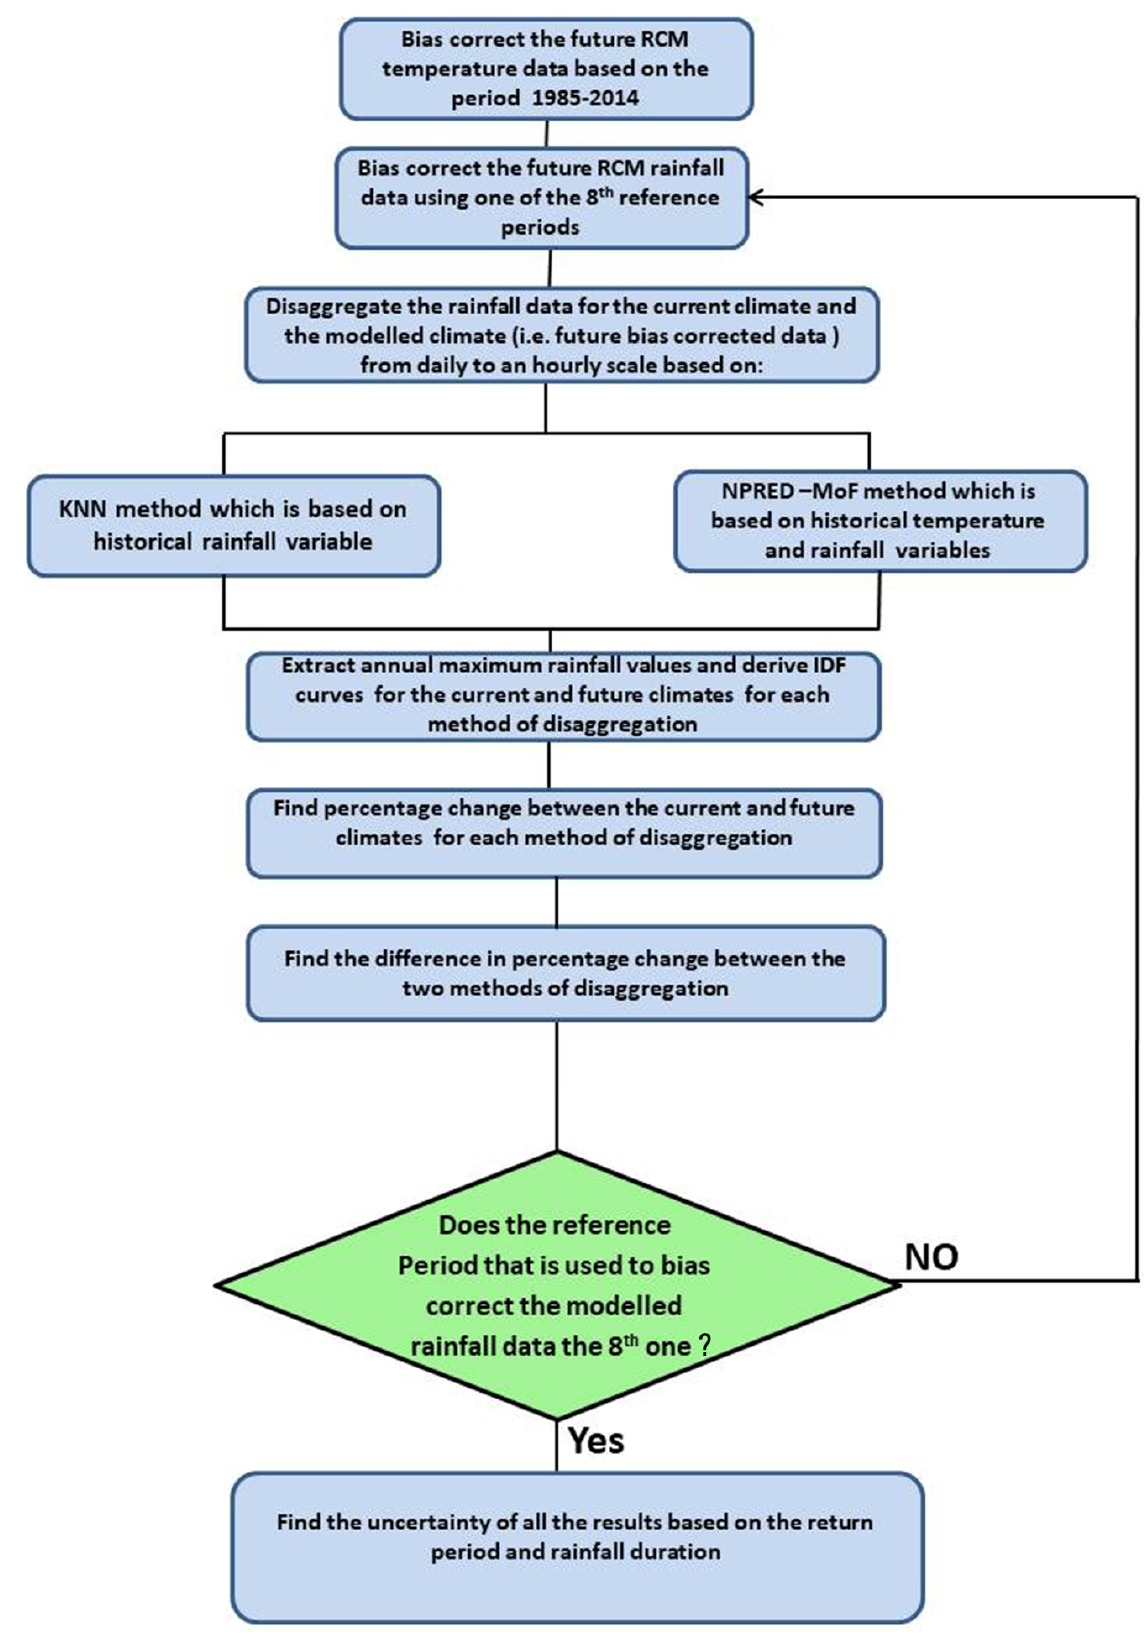
Figure 1. Flowchart for the process of creating IDF curves.